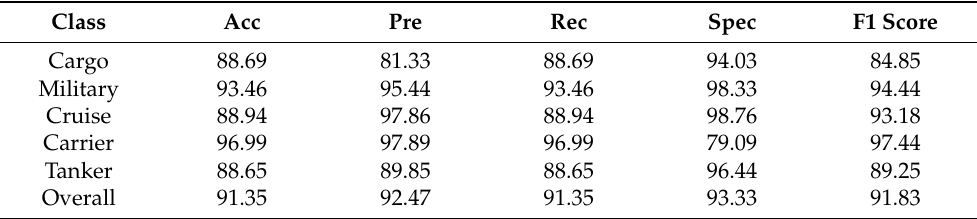
Table 5. Evaluation metrics of proposed classification algorithm for the MARVEL